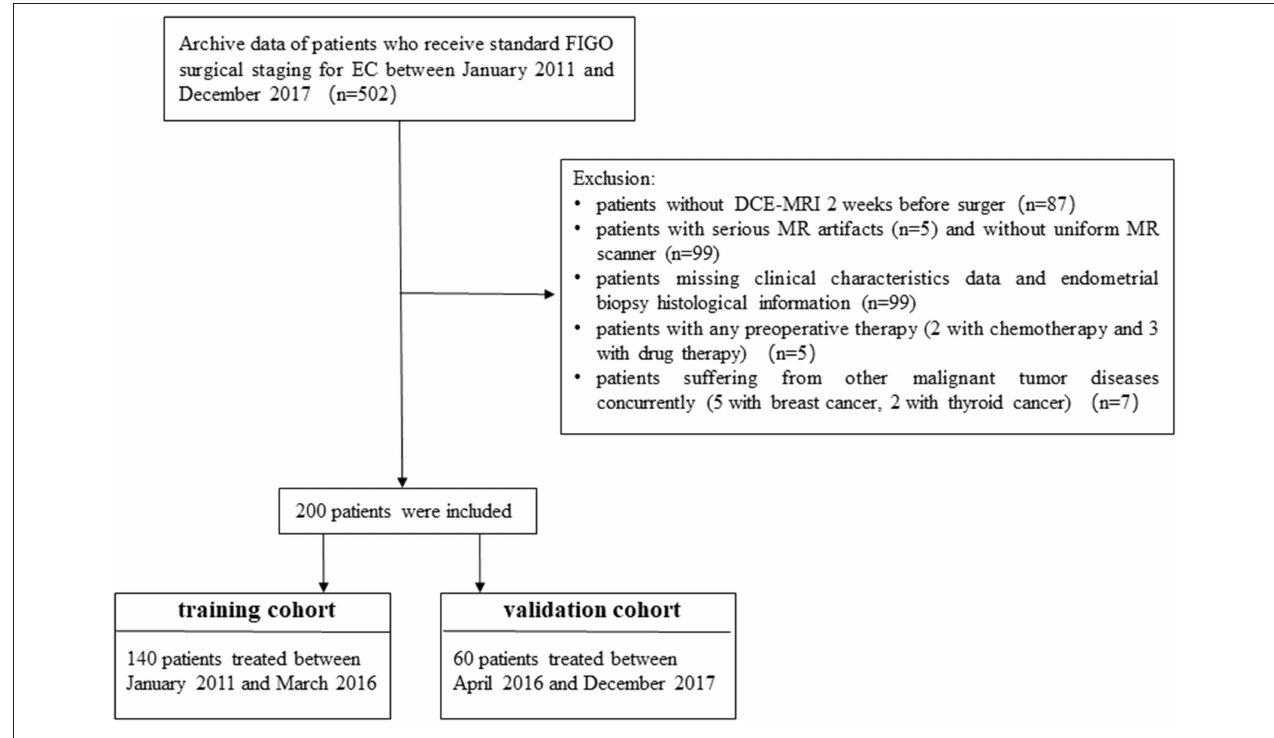
FIGURE 1 | Recruitment pathway for patients in this study.